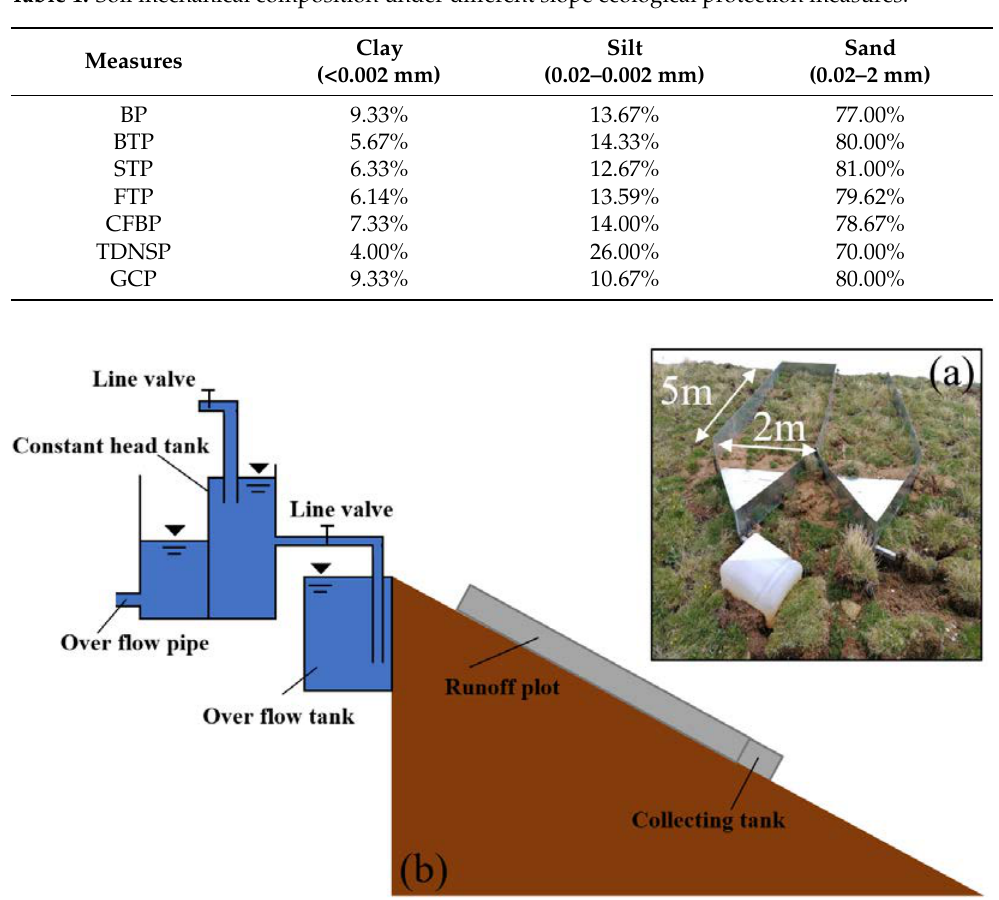
Figure 4. Runoff plots and experimental inflow setup. ( a ) The layout of runoff plots. ( b ) The inflow setup.